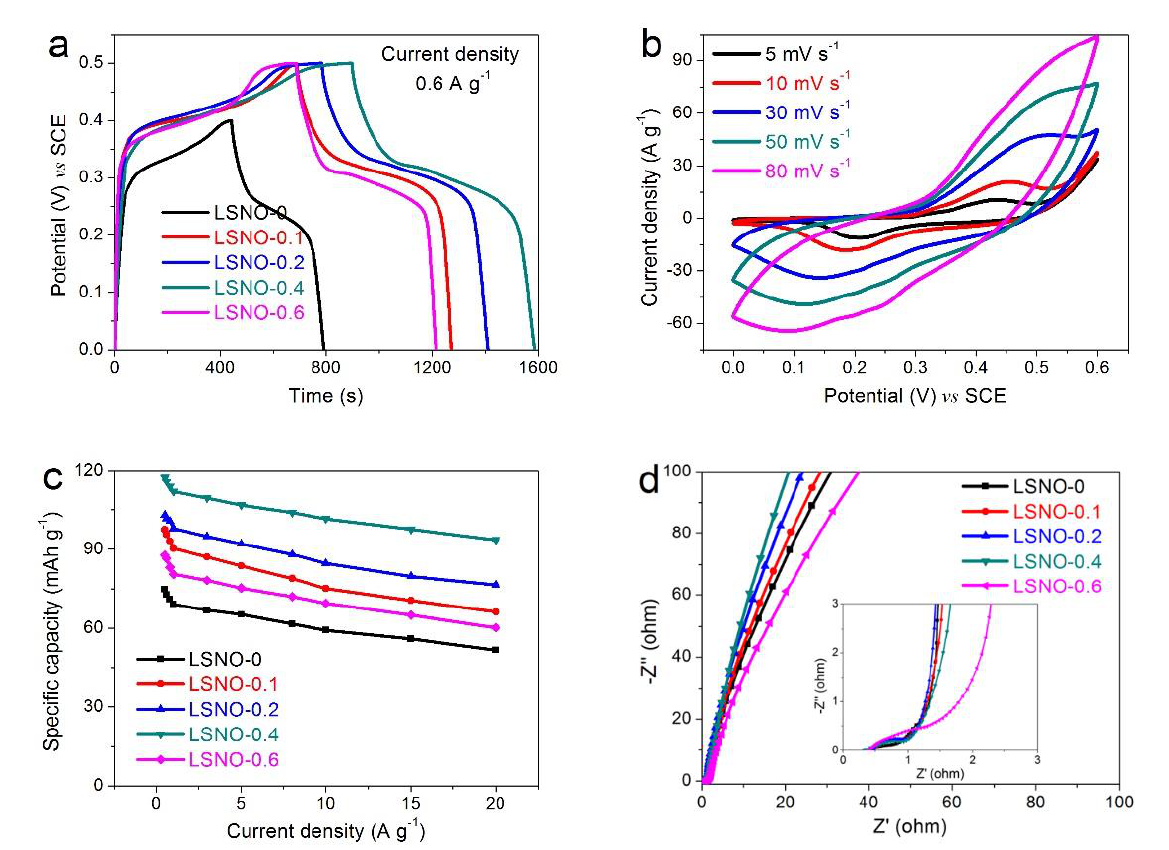
Figure 5. The electrochemical performances of all electrodes in a three-electrode system with 6 KOH aqueous solution as electrolyte: ( a ) galvanostatic charge discharge (GCD) curves of the LSNO-0, LSNO-0.1, LSNO-0.2, LSNO-0.4, and LSNO-0.6 samples at current density of 0.6 A g − 1 ; ( b ) cyclic voltammetry (CV) curves of LSNO-0.4 electrode at different scan rates ranging from 5 mV s − 1 to 80 mV s − 1 ; ( c ) Specific capacity vs. Current density, ( d ) Nyquist plots.